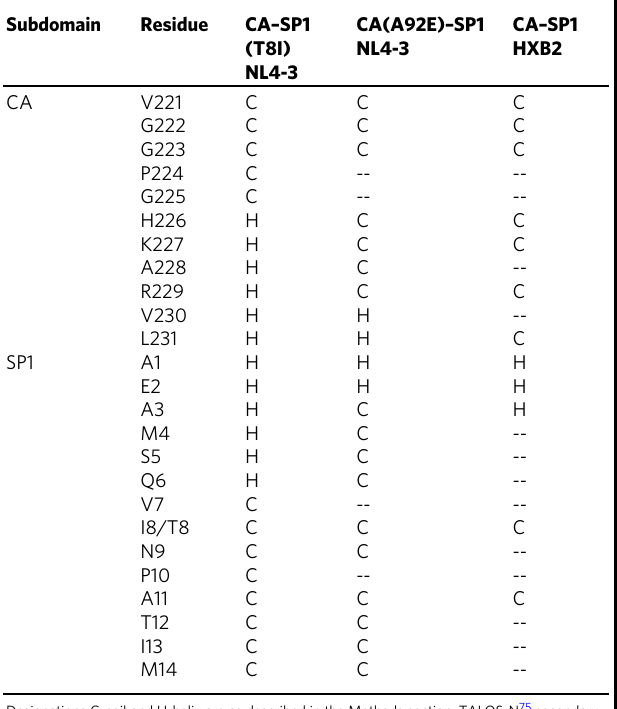
Table 1 CSI 2.0 secondary structure prediction based on experimental chemical shifts for CA – SP1(T8I) NL4-3,